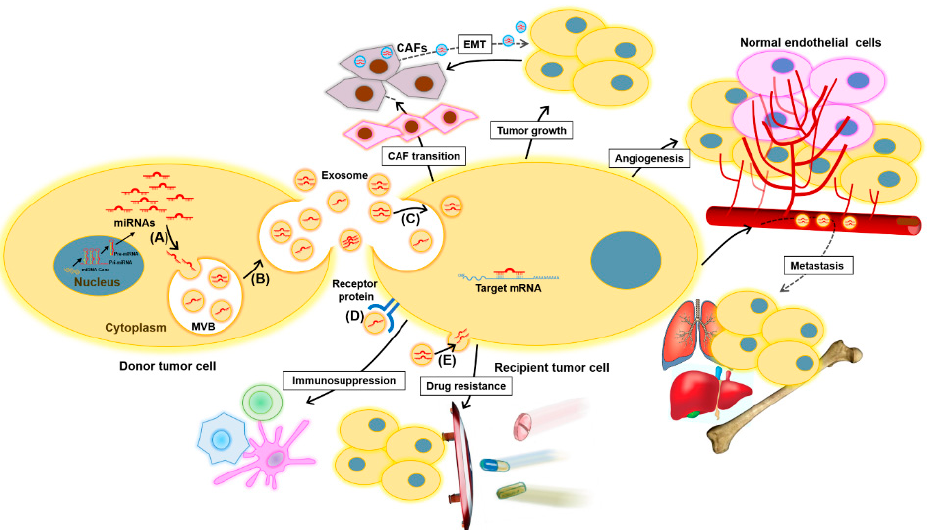
Figure 2. Functions of exomiRs in cancer. ExomiRs play multiple roles in tumor initiation and development. Tumor cells may transfer exomiRs to the surrounding normal or tumor cells as follows: (A) the sorting of miRNAs into exosomes during MVB formation, (B) the release of exosomes into the extracellular space, (C) the delivery of exomiRs to recipient cells by endocytosis, (D) the binding of exosomes to receptors to activate specific signaling pathways, and (E) the fusion of exosomes with the plasma membrane of recipient cells. Subsequently, the transmitted exomiRs can regulate tumor cell growth, angiogenesis, and metastasis by binding to their downstream targets. Drug-resistant tumor cells can transmit their resistant phenotype to drug-sensitive tumor cells through the transfer of ex- omiRs that confer chemoresistance. Moreover, tumor-derived exomiRs play a key role in exchanging information between tumor cells and immune cells, such as macrophages, T cells, and dendritic cells, to suppress the immune response and promote tumor progression. Tumor-derived exomiRs are also instrumental modulators of the tumor microenvironment, inducing CAF transition, thus facilitating tumorigenesis and tumor development. On the other hand, fibroblast-derived exomiRs are also transferred to tumor cells and can contribute to EMT. CAF, cancer-associated fibroblast; EMT, epithelial–mesenchymal transition; ExomiR, exosomal miRNA; and MVB, multivesicular